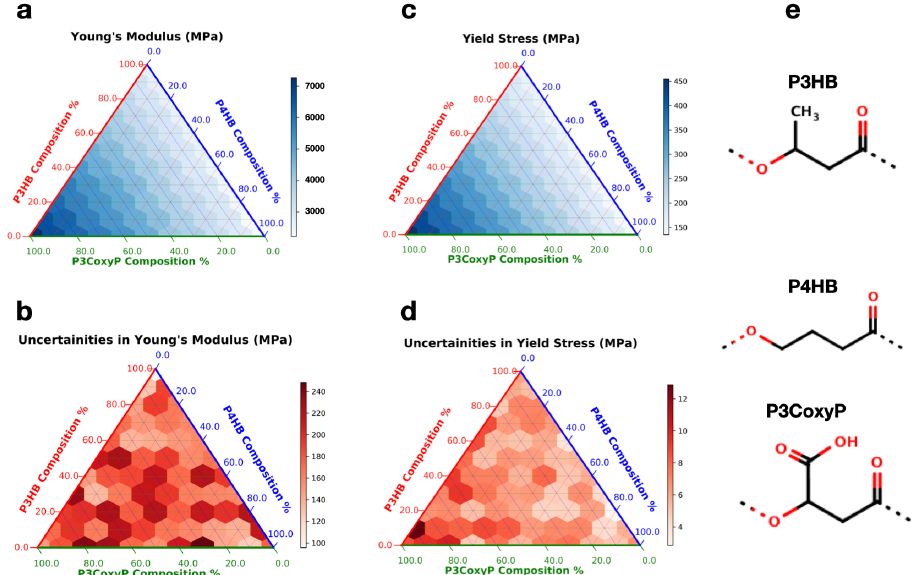
Figure 4. Mechanical properties and associated uncertainties (in MPa) of a ternary polymer P4HB– P3HB–P3CoxyP: ( a , c ) represent the ternary plots of Young’s modulus and yield stress, while the associated uncertainties are shown in ( b , d ). The chemical structures of the polymers are displayed in ( e ). Simulations were conducted at 300 K applying strain of 1 × 10 9 s − 1 . At each composition, a total of 15 independent simulations were performed to determine the mean and associated